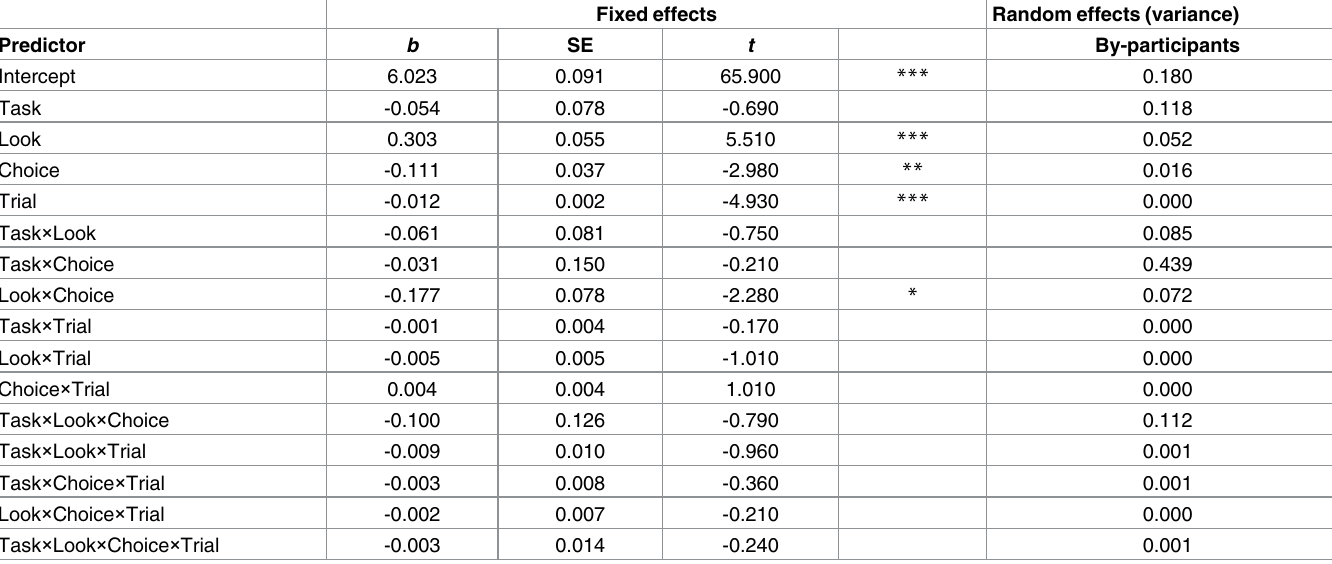
Table 2. Generalized linear mixed models fitting the first dwell time in the wine block in Experiment